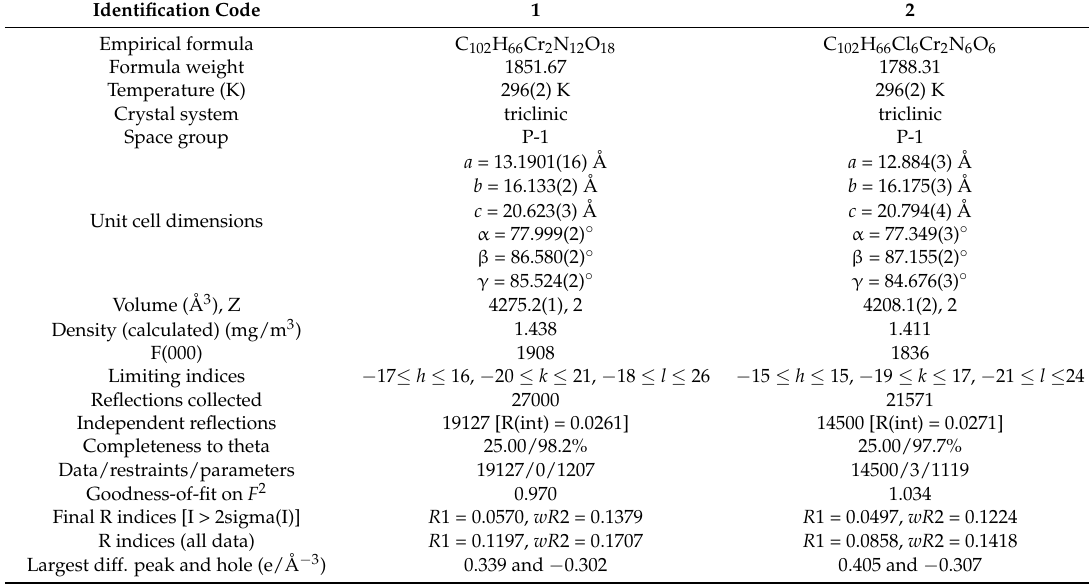
Table 1. Crystal data and structure refinement for compounds 1 and 2 .